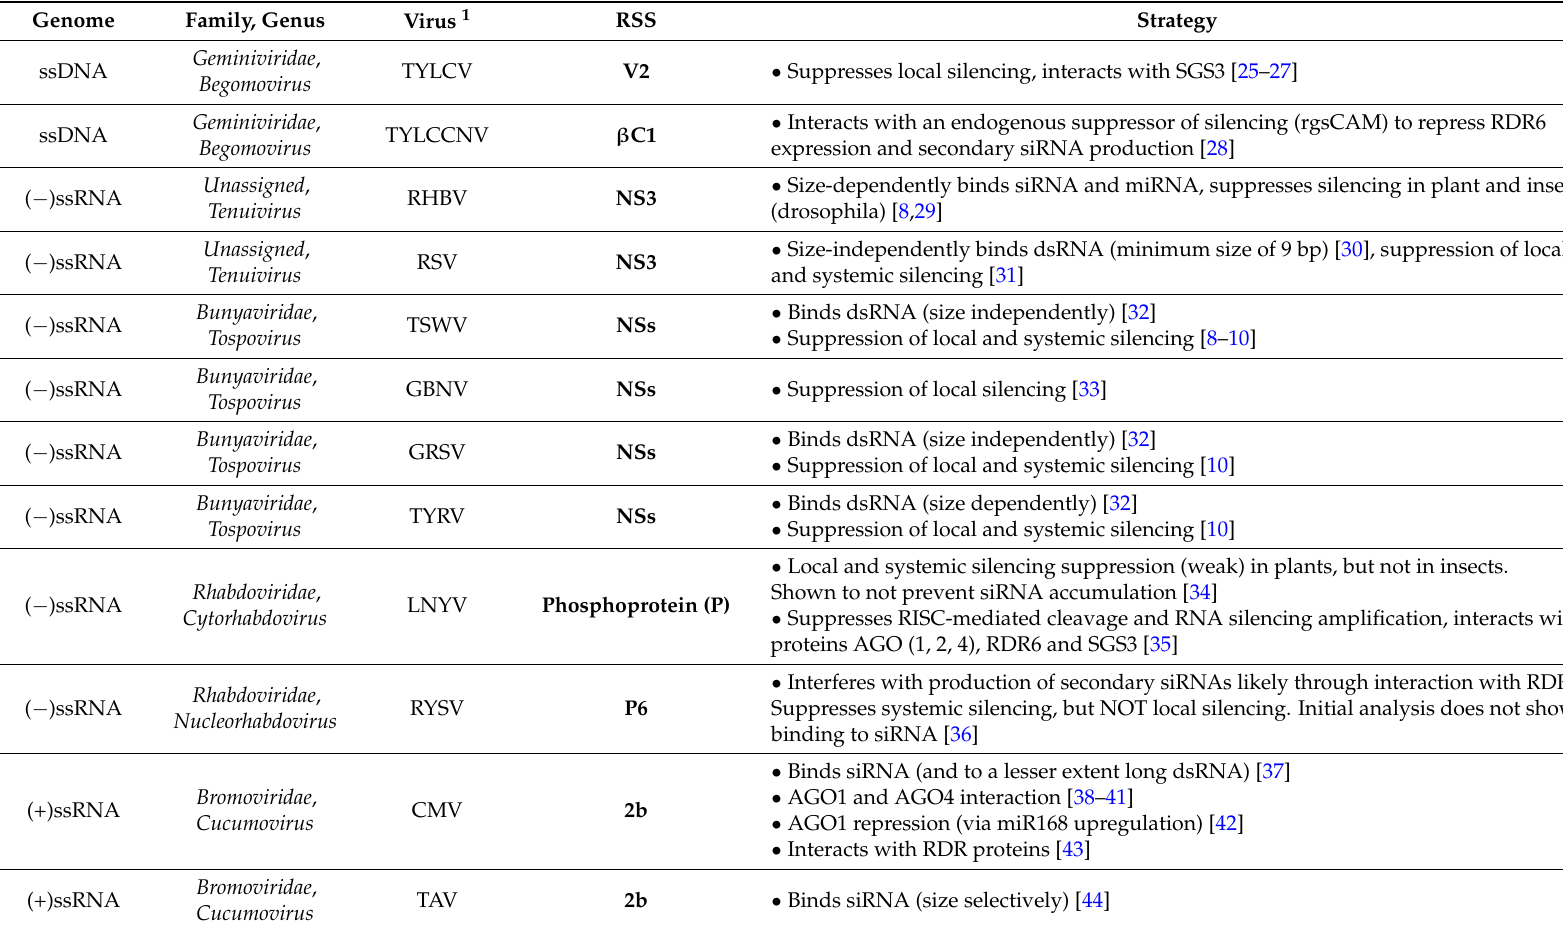
Table 1. List of identified RNA silencing suppressors (RSS) from plant-infecting viruses, and the respective strategy used to suppress the RNA silencing machinery. Genome Family, Genus Strategy Geminiviridae , ssDNA